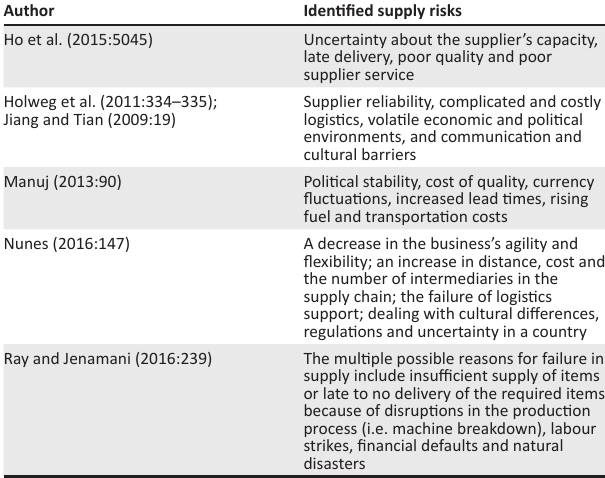
TABLE 2: Identified supply risks associated with global sourcing